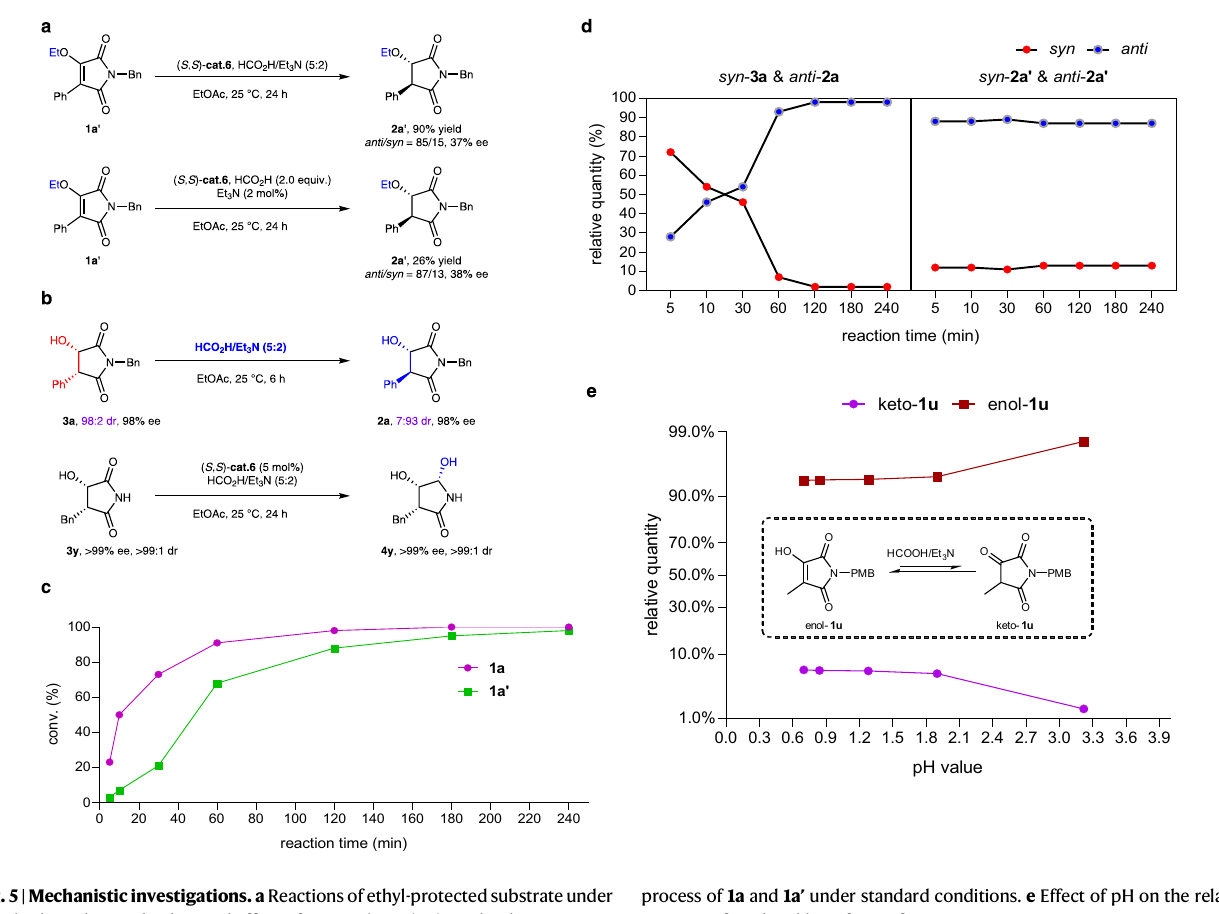
process of 1a and 1a ’ under standard conditions. e Effect of pH on the relative quantity of enol and keto form of 1u